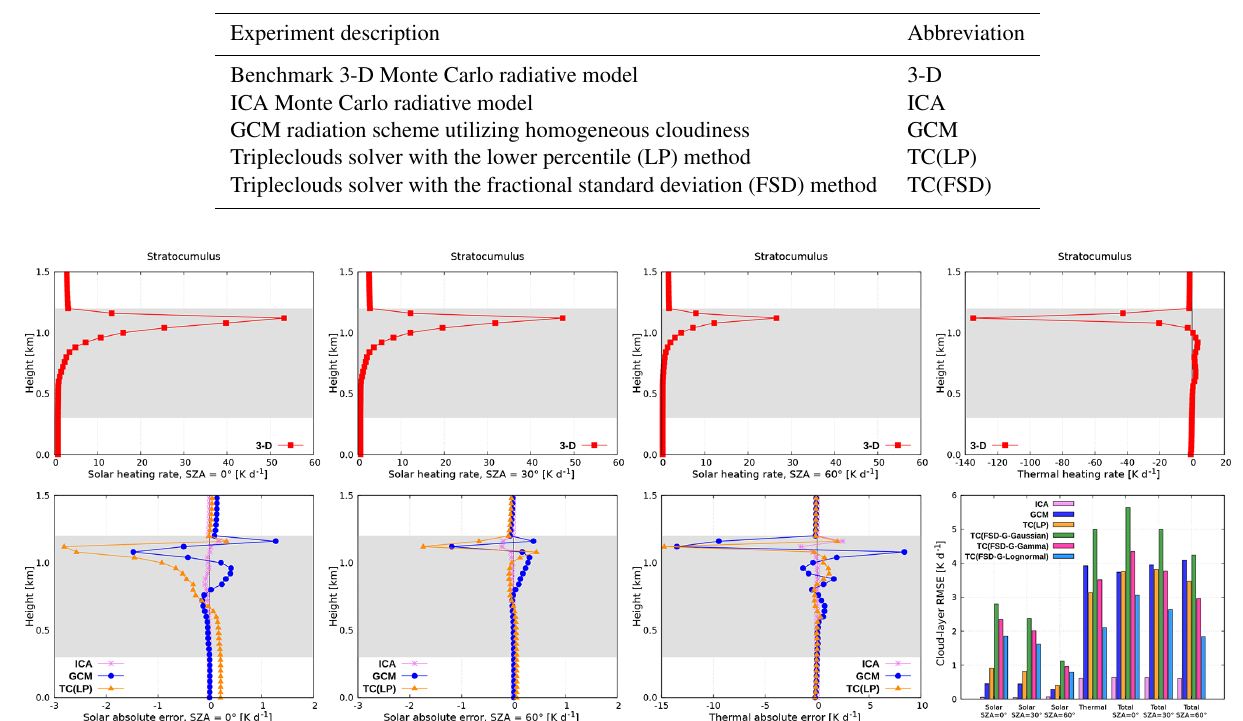
Figure 5. Radiative heating rate for the stratocumulus cloud. The gray-shaded area denotes the cloud